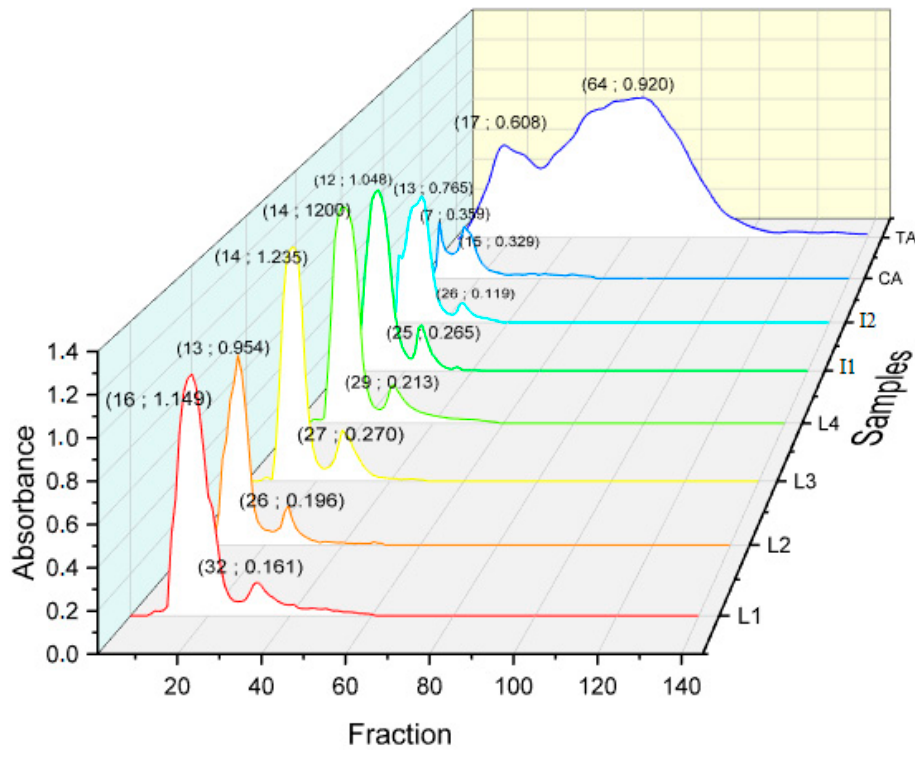
Figure 5. Molecular distribution of pomegranate varieties extracts (L1, L2, L3, L4, I1, and I2) catechin (CA) and tannic acid (TA). Inset: (fraction N°; absorbance).